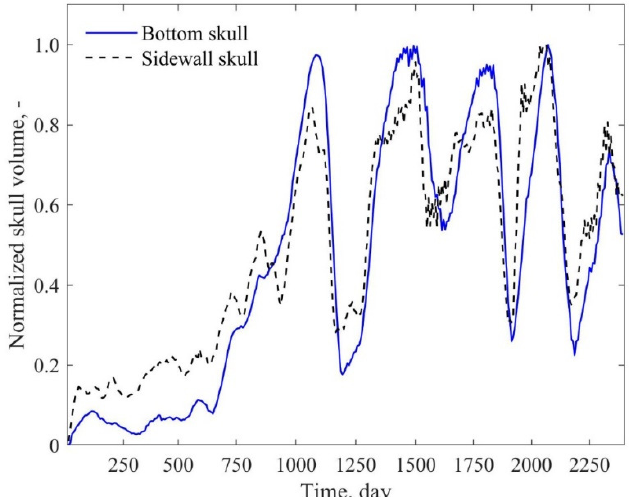
Figure 7. Evolutions of the normalized volumes of bottom skull (solid line) and sidewall (dashed line) skull.